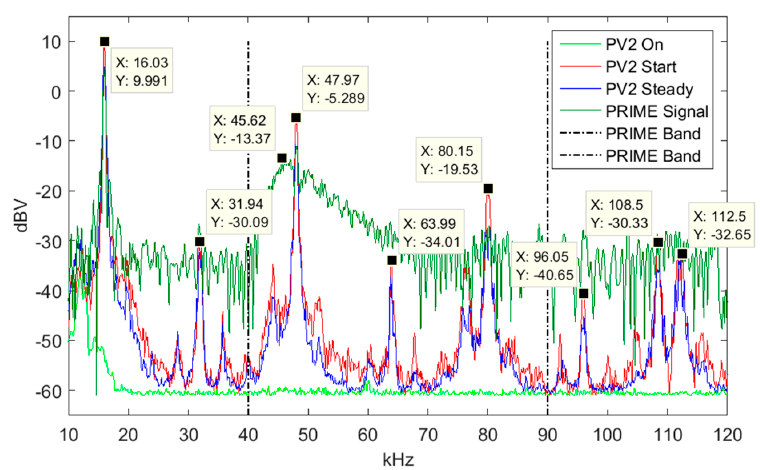
Figure 10. Spectrum recorded at the PV2 SM with the rest of devices disconnected.